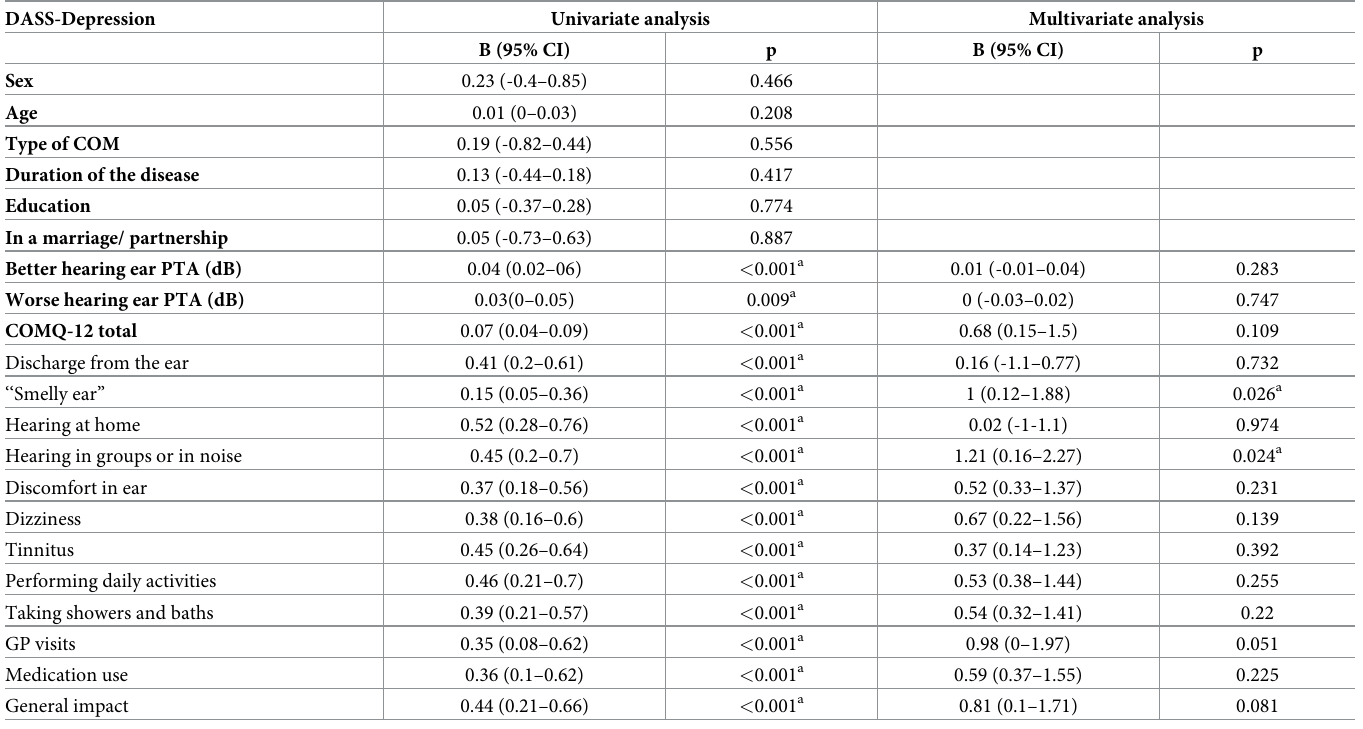
Table 4. Univariate and multivariable logistic regression for DASS-depression